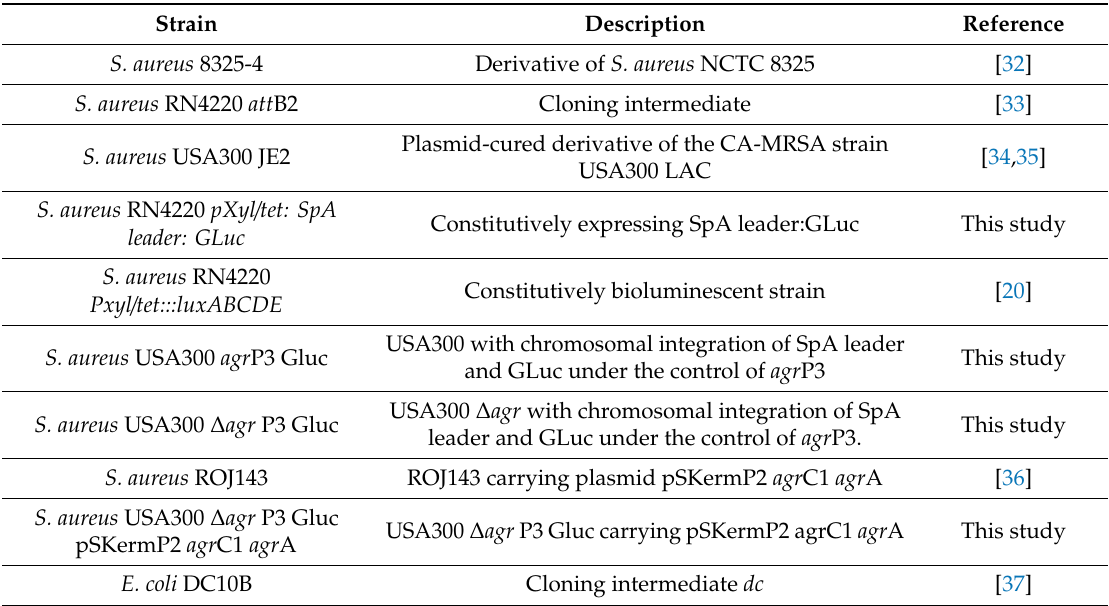
Table 1. Bacterial strains used in this study.